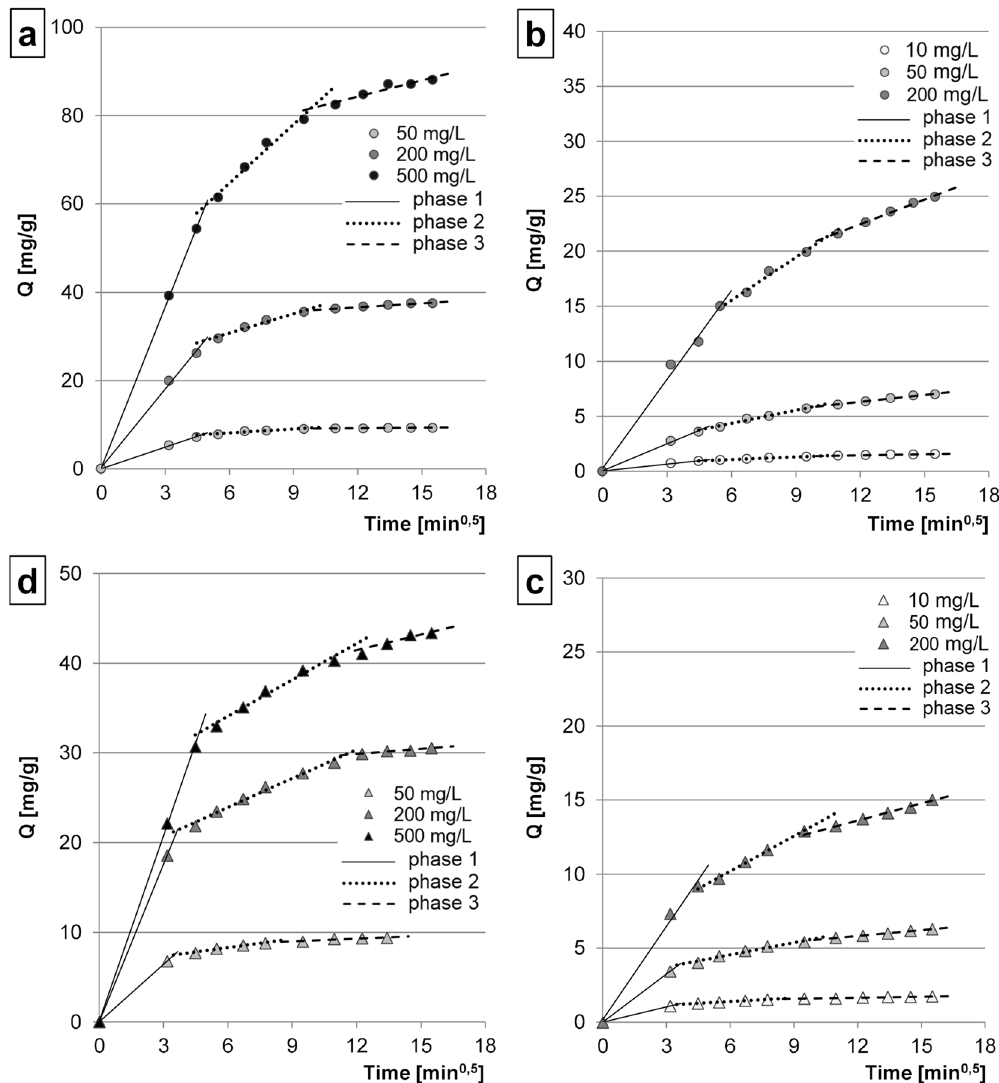
Figure 3. The intramolecular diffusion model of sorption of: ( a ) BR46 onto CG; ( b ) BV10 onto CG; ( c ) BR46 onto GTL; and ( d ) BV10 onto GTL. Temp. 22